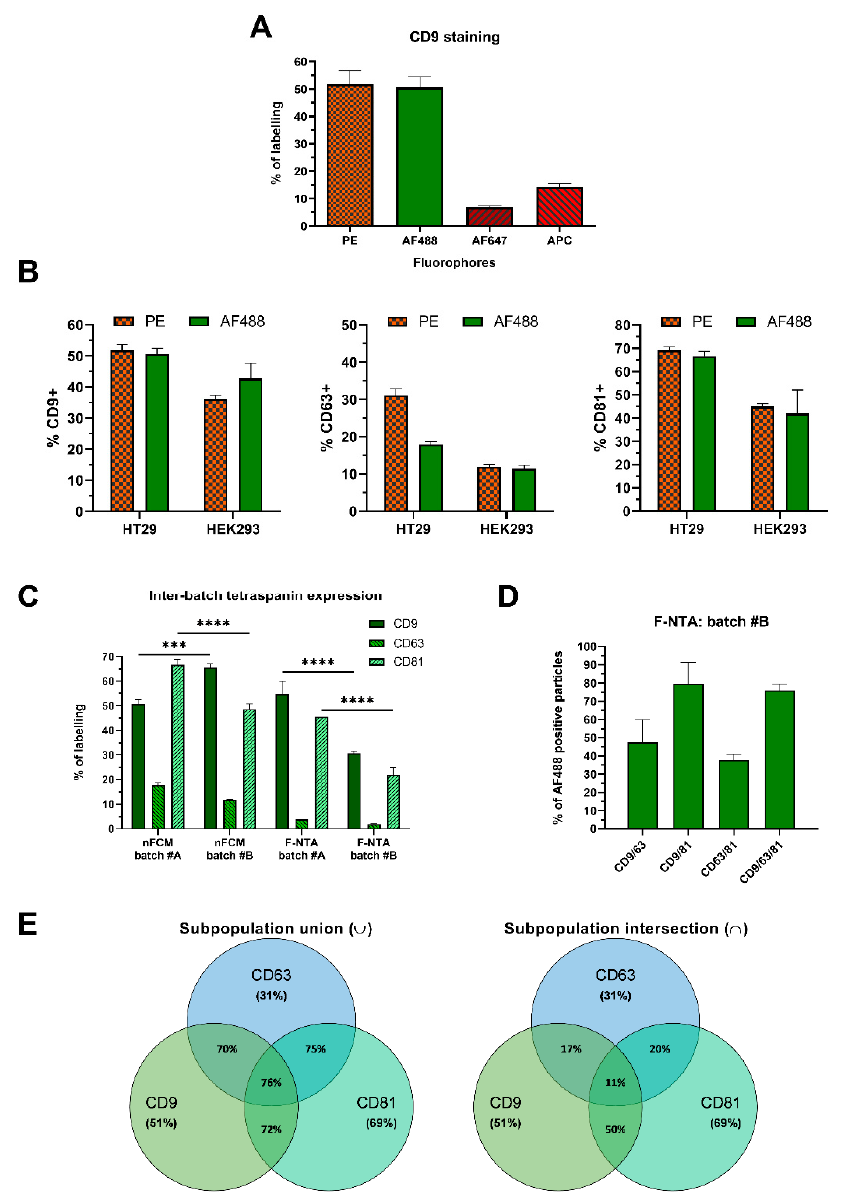
Figure 2. Characterization of purified sEV subpopulations based on their surface markers. ( A ) Antibody staining efficiency was evaluated by nFCM using anti-CD9 antibodies conjugated with different fluorophores. ( B ) HT29 and HEK293 sEVs were stained with anti-tetraspanin (CD9, CD63, and CD81) antibodies, conjugated with either PE or AF488, and analyzed on nFCM ( n ≥ 3; mean ± SEM). ( C ) Cross-platform and inter-batch variability was assessed by single-staining HT29 sEV (batches #A and #B) with anti-tetraspanin AF488 antibodies ( n = 3; mean ± SEM). Differences in tetraspanin expression between nFCM and F-NTA, and batches #A and #B, were assessed using two-way ANOVA with Tukey’s test for multiple comparisons (alpha = 0.05, p = 0.1234 (ns), 0.0002 (***), <0.0001 (****)). Detailed results of the statistical analysis are provided as supplementary material. ( D ) To evaluate single, as well as co-expressing, events, HT29 sEVs were stained with a mix of 2 and 3 different anti-tetraspanin AF488 antibodies and analyzed on F-NTA ( n = 3; mean ± SEM), or on ( E ) nFCM using PE-conjugated antibodies ( n = 3; mean ± SEM). HT29 sEV subpopulations expressing either 1, 2, or 3 markers are represented in the Venn diagram on the left. The Venn diagram on the right refers to the same HT29 sEVs, however it depicts subpopulations co-expressing both 2 or 3 markers simultaneously. Additional data from procedural controls, as well as the F-NTA PSD histograms, are provided in Supplementary Figure